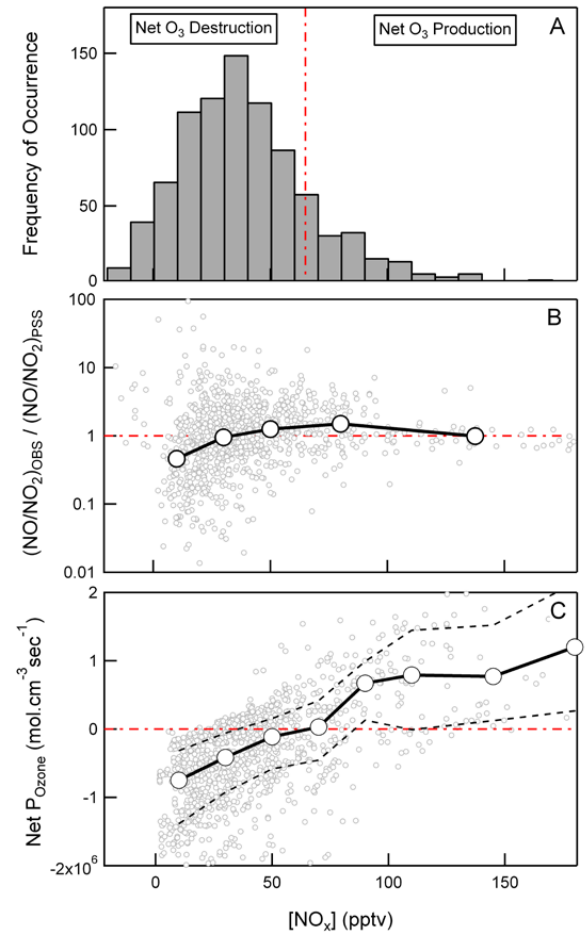
Fig. 7. (A) Observed frequency distribution of NO x below 6km. (B) Figure 7 : (A) Observed frequency distribution of NO x below 6 km. (B) Ratio of the observed 597 Ratio of the observed NO 2 /NO, compared with that calculated from NO 2 /NO, compared with that calculated from photo-stationary steady state (Eq. 9). (C) 598 photo-stationary steady state (Eq. 4). (C) Calculated instantaneous Calculated instantaneous net ozone production rate as a function of observed NO x 599 net ozone production rate as a function of observed NO x concentra- concentrations. Observations were filtered to strong remove stratospheric influence 600 tions. Observations were filtered to strongly remove stratospheric influence (O 3 /CO > 1.25) and are for the northern pacific sampling (O 3 /CO>1.25) and are for the northern pacific sampling region (Latitude > 35ºN). 601 region (Latitude > 35 ◦